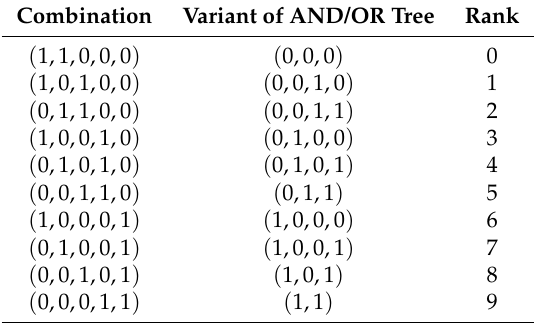
Table A2. Ranking the combinatorial set of m -combinations of n elements for n = 5 and m = 2.